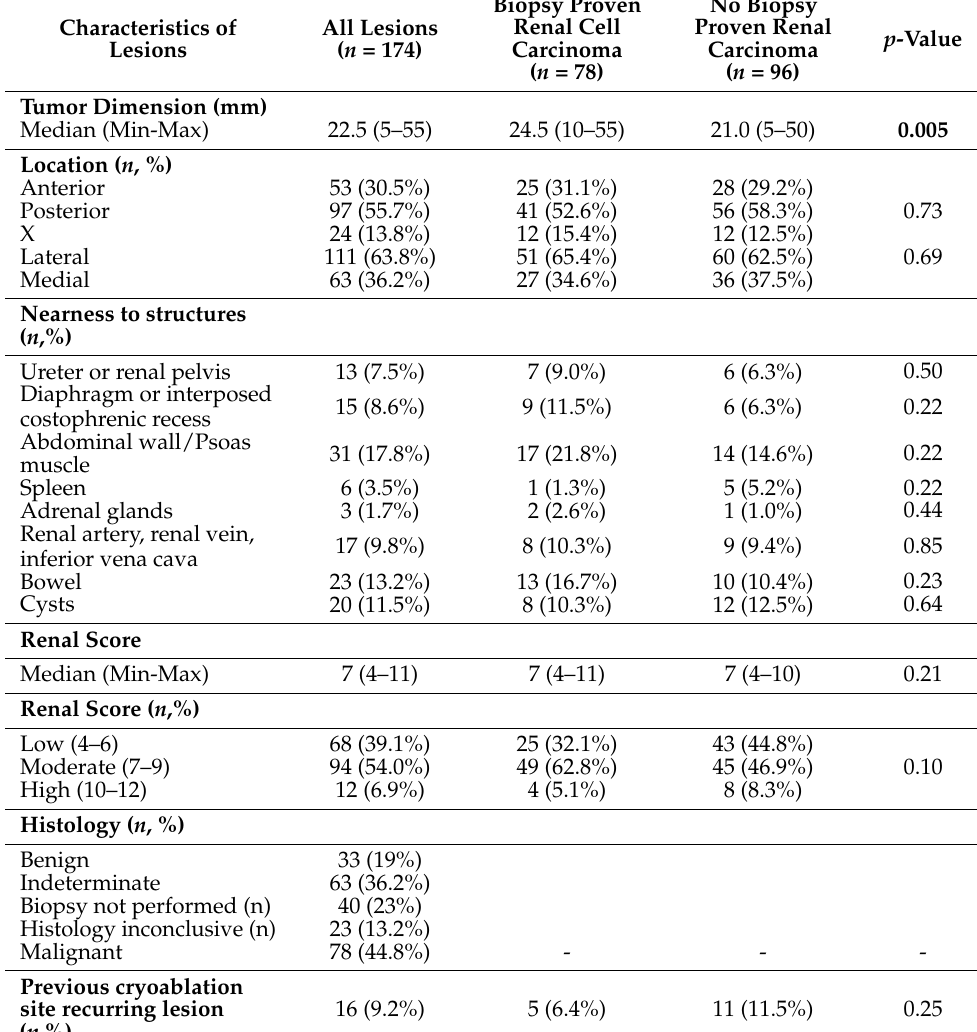
Table 2. Characteristics of treated